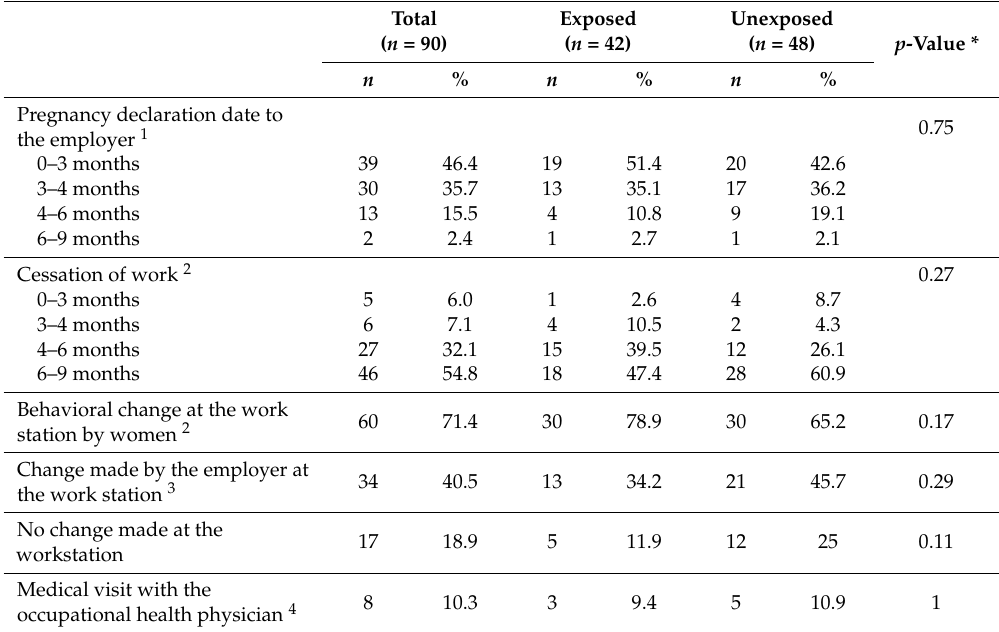
Table 3. Actions implemented in the workplace during the pregnancy ( n = 90).